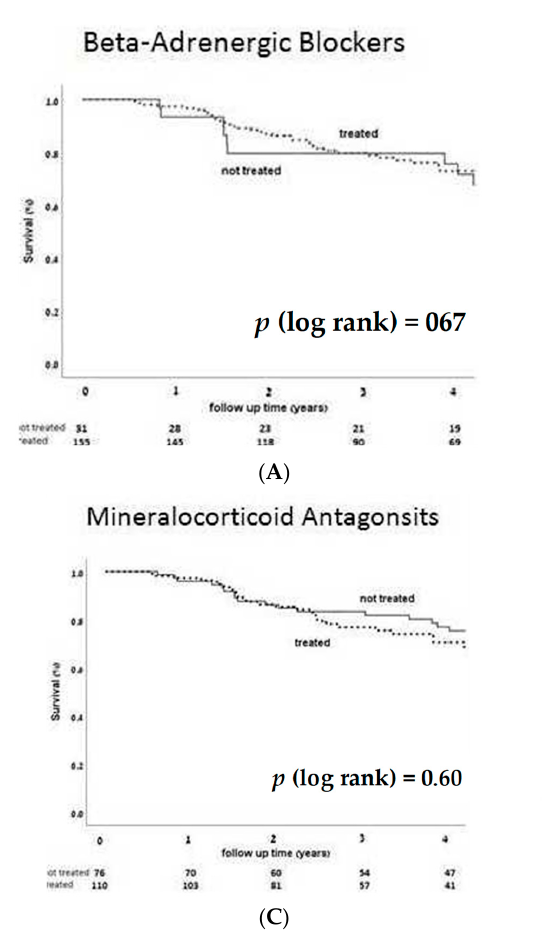
Figure 3. Overall survival KM curves according to heart failure medication treatment groups (regardless of dose), including BB ( A ), AngA ( B ), and MRA ( C ), revealing reduced mortality in patients treated with angiotensin antagonists. p < 0.05 is considered significant.